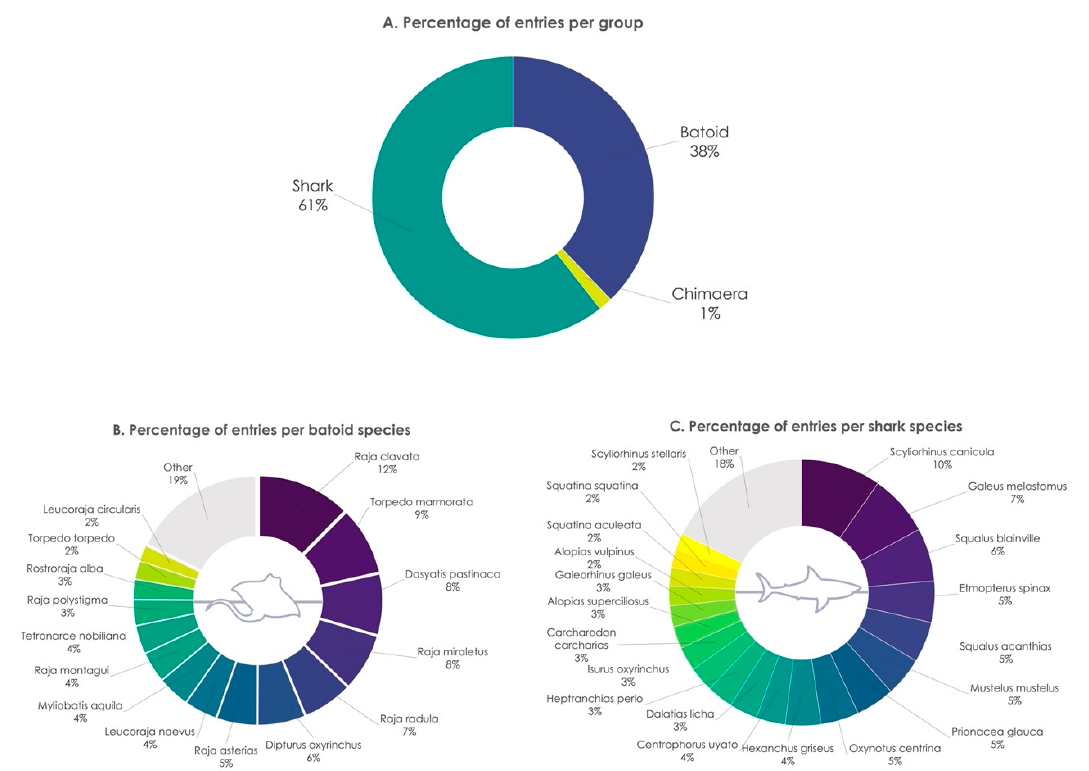
Figure 1. ( A ). Percentage of entries per group of chondrichthyans in Greek waters ( B ) . Percentage of entries examined per species for batoids ( C ). Percentage of records per species for sharks. Species with less than 2% of records are not shown in the graph but can be found in Table 1.